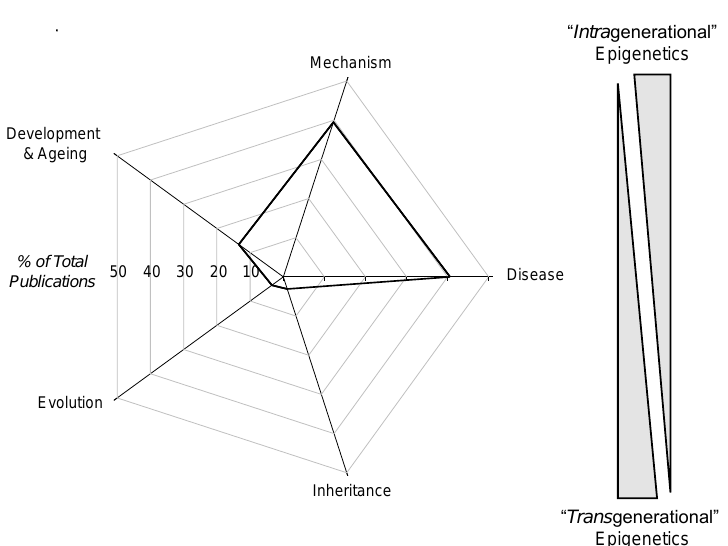
Figure 1. Radar diagram showing the relative distribution of publications drawn from the PubMed database (http://www.ncbi.nlm.nih.gov/pubmed/) that contain the search terms “epigenetic(s)” and one of five focus areas. The graphic to the right indicates a gradient between intragenerational and transgenerational epigenetics based on the percentage of epigenetic papers emerging from each area of study indicated in the radar diagram. Thus, epigenetic papers with the terms “development and ageing” or “disease” are assumed to be more likely to be addressing intragenerational issues, such as evolution, while epigenetic papers mentioning “evolution” or “inheritance” are viewed as more likely to be focusing on transgenerational epigenetic events. See the text for an additional discussion.